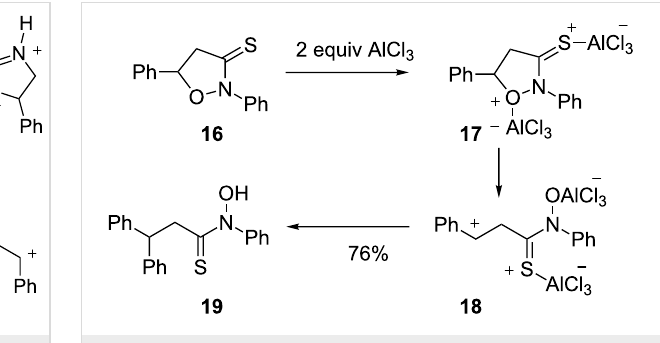
Scheme 2: Ring opening of diprotonated 2-oxazolines. Scheme 3: AlCl 3 -promoted ring opening of isoxaolidine 16